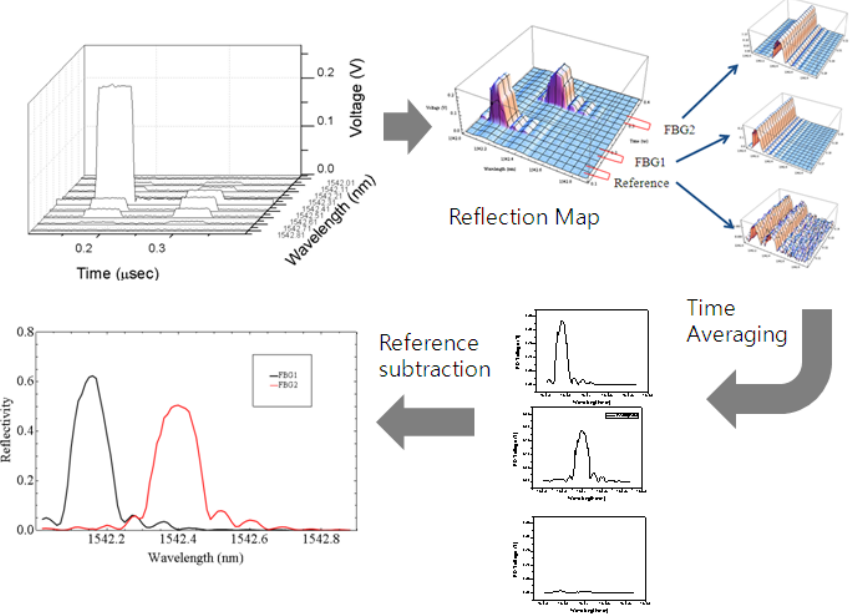
Figure 3. Signal processing procedure to get the each reflection spectrum from the WDM/TDM